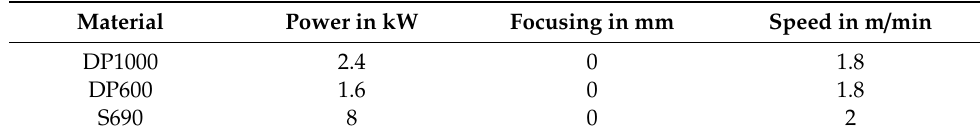
Table 3. Welding parameters of the LBW.